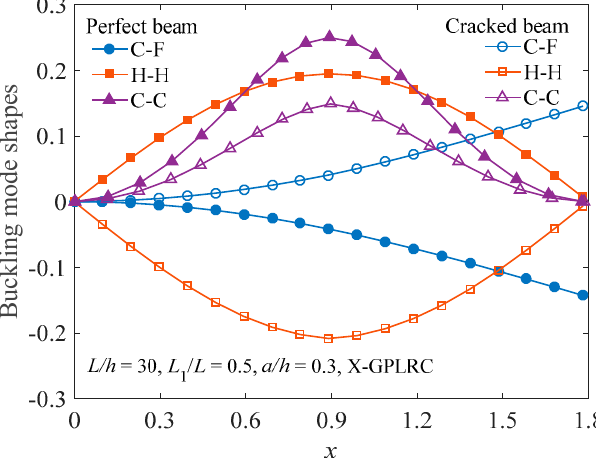
Figure 8. Comparison of buckling mode shapes of intact and cracked FG-X-GPLRC beams.